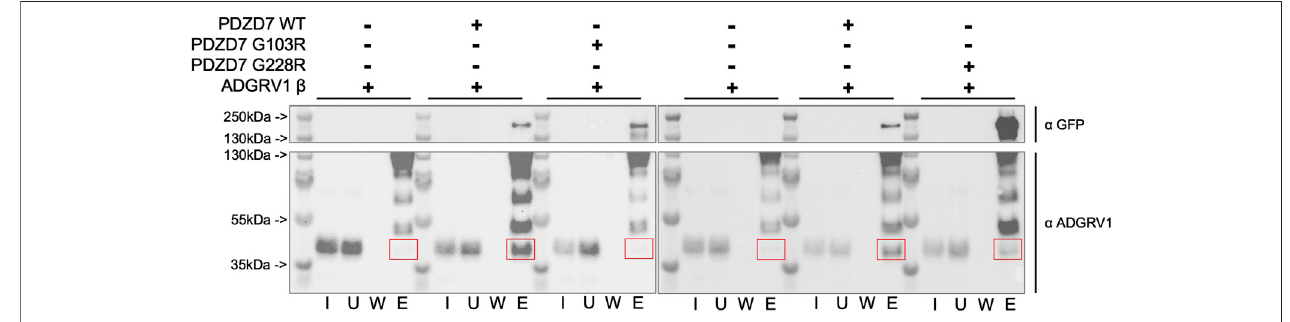
FIGURE 5 | Western blot detection of ADGRV1 β subunit (prey) pulled down by PDZD7-GFP (bait) constructs from HeLa cell lysates. PDZD7 constructs are detectedwithanantibodydirectedagainstthefusedGFP.ADGRV1isdetectedusinganantibodydirectedagainstitscytoplasmicdomain. Foreachcondition,fractions correspondingtotheinput(I),unboundfraction(U), wash(W)and elution(E)areloaded. RedsquaresindicatetheexpectedpositionforADGRV1 β